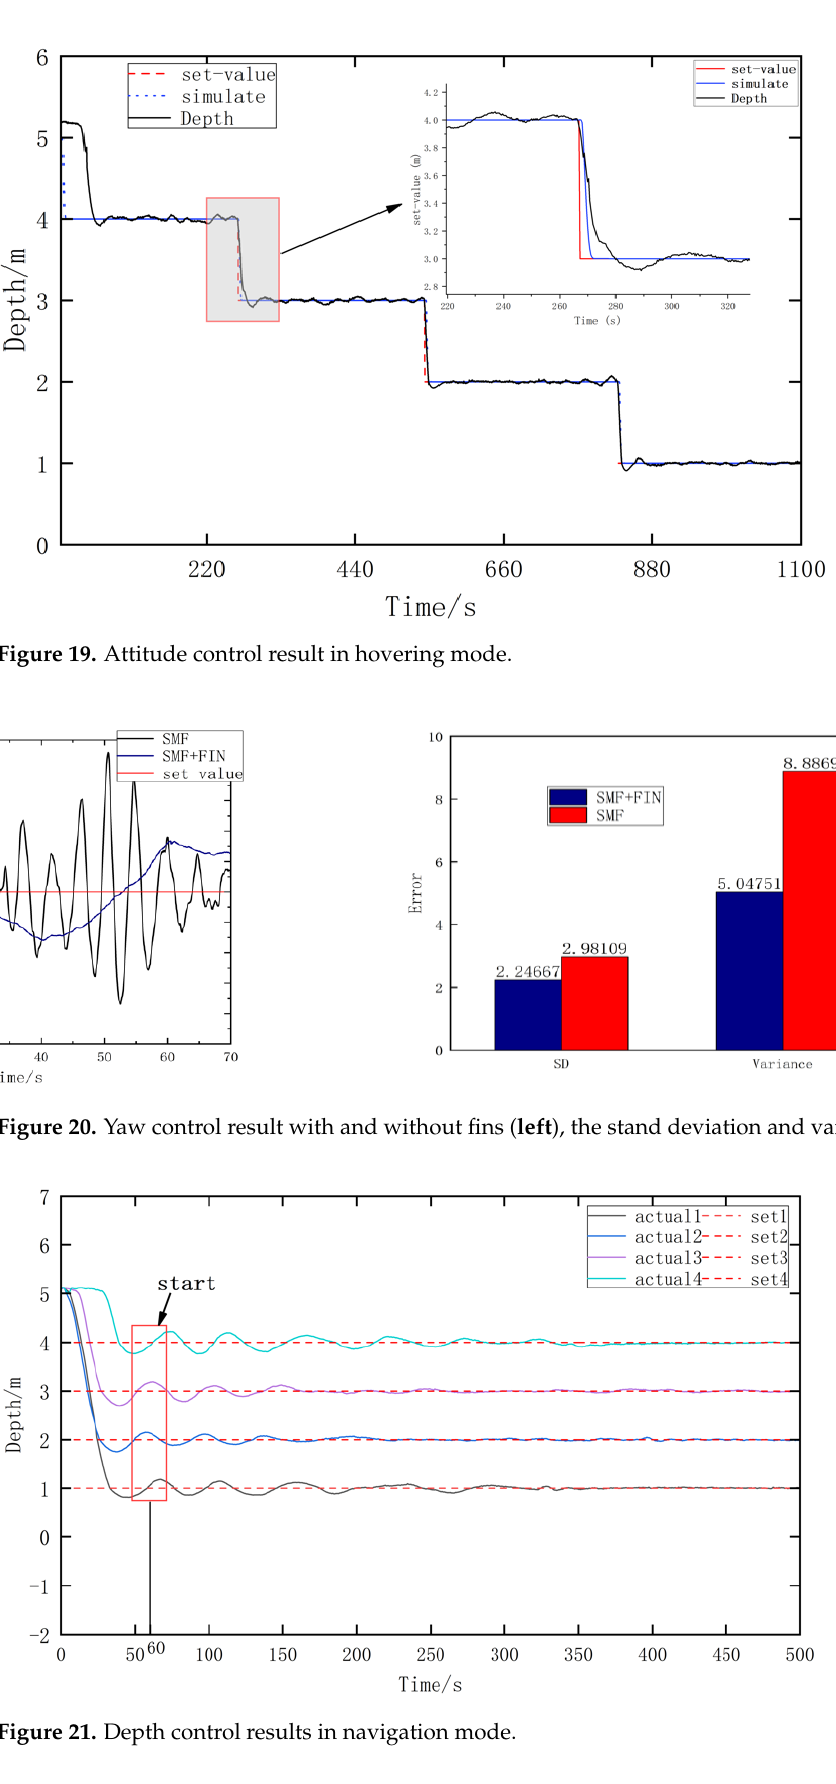
Figure 22. Attitude control results in navigation mode.